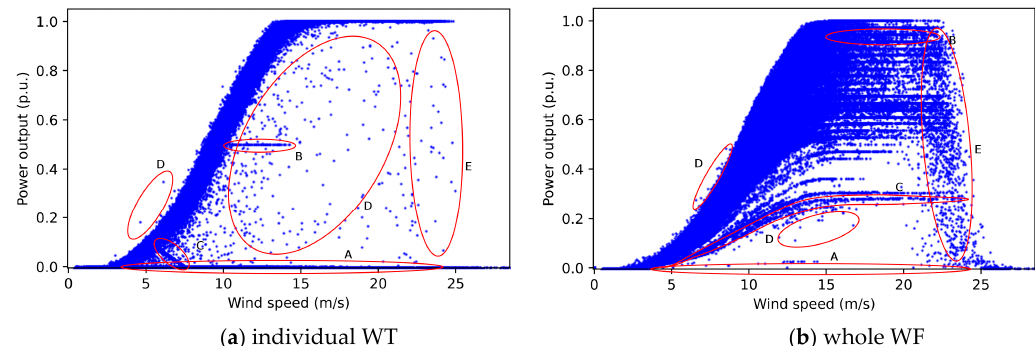
Figure 1. Actual 3-year measurements with indicated different types of outliers for an individual WT.